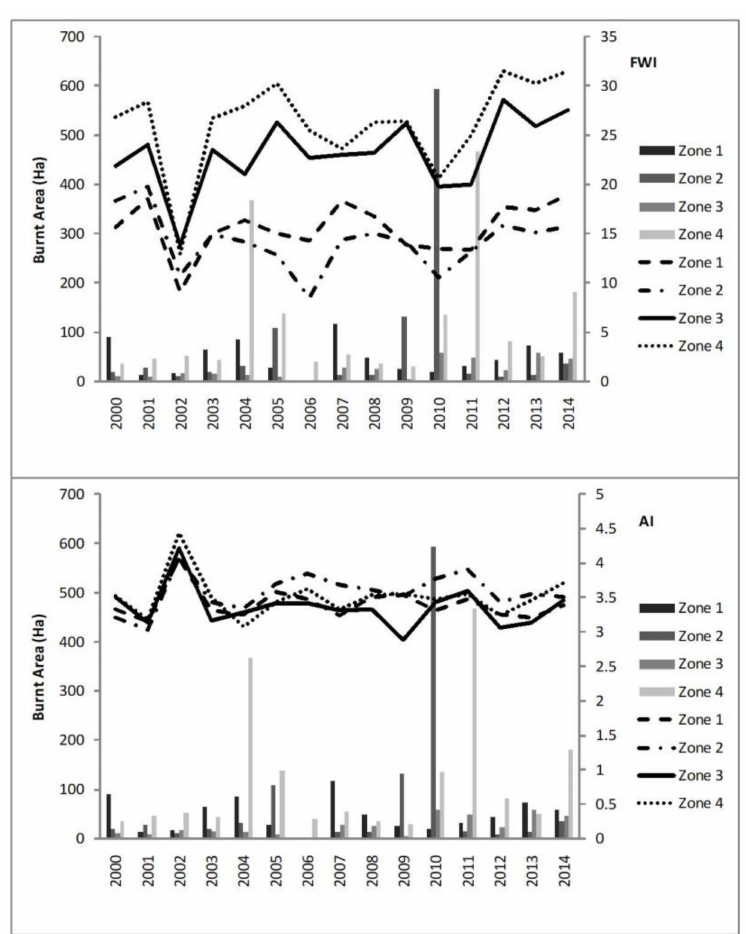
Figure 2. Evolution of burned area in ha (bar chart) and Forest Weather Index (FWI) and Angström Index (AI) average on fire days (line chart) in the 2000–2014 period (left and right,